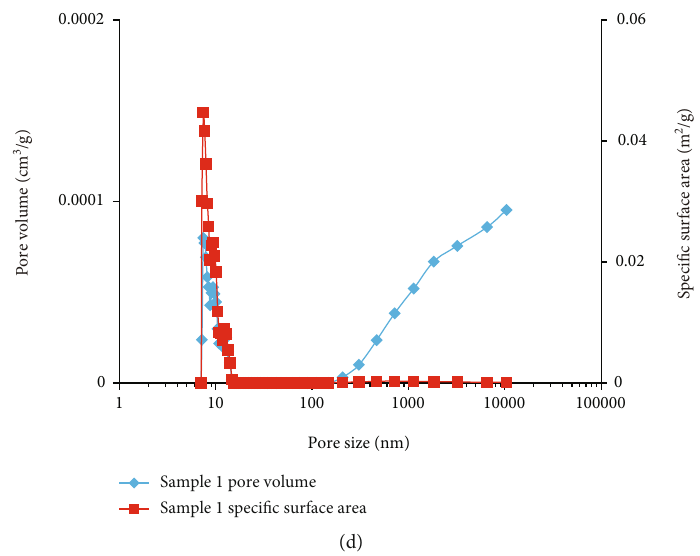
Figure 2: Typical sample mercury intrusion-extrusion curves and pore size distribution of